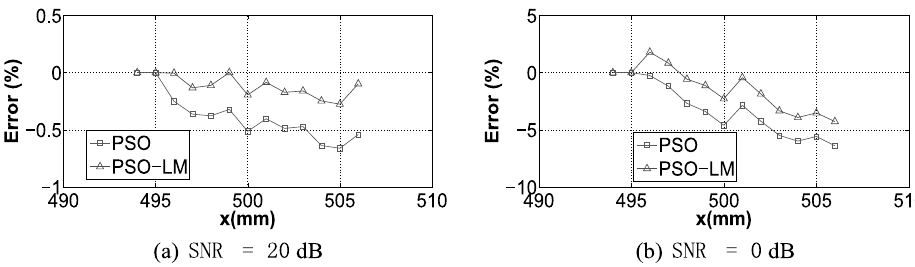
Fig. 20. Relative error in the identi fi cation for a low (0 dB) and moderate (20 dB) levels of SNR, Case 4.